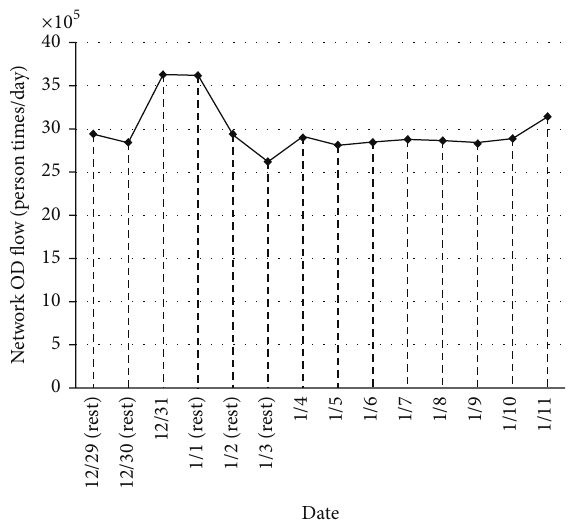
Figure 1: OD flow of Guangzhou Metro around New Year’s